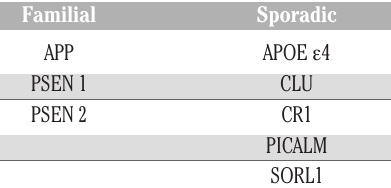
Table 1. The genes associated with familial and sporadic Alzheimer’s